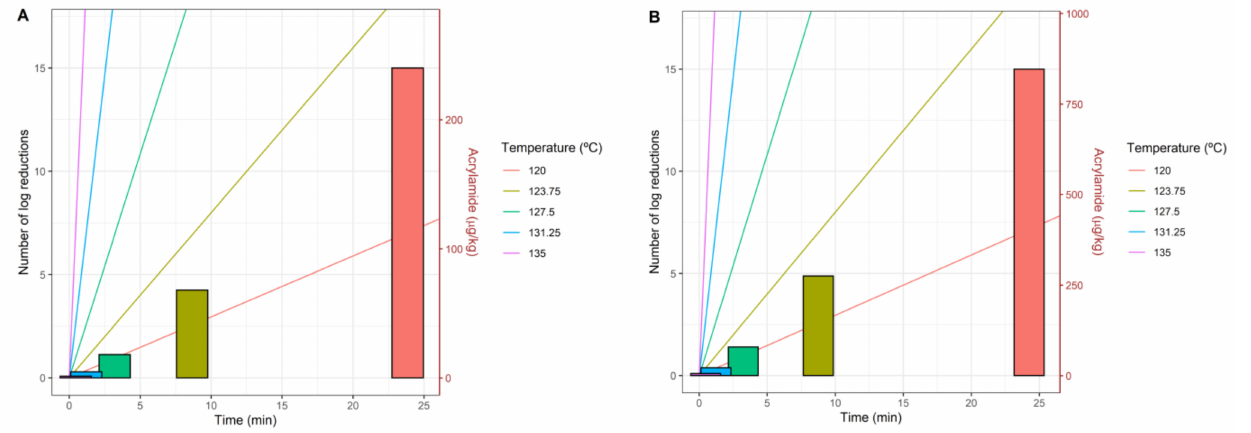
Figure 5. Inactivation rates represented as lines and acrylamide formed represented as bars for different temperatures when P ( log 10 S ≥ 6 ) = 0.95, potato puree ( A ) and prune juice ( B